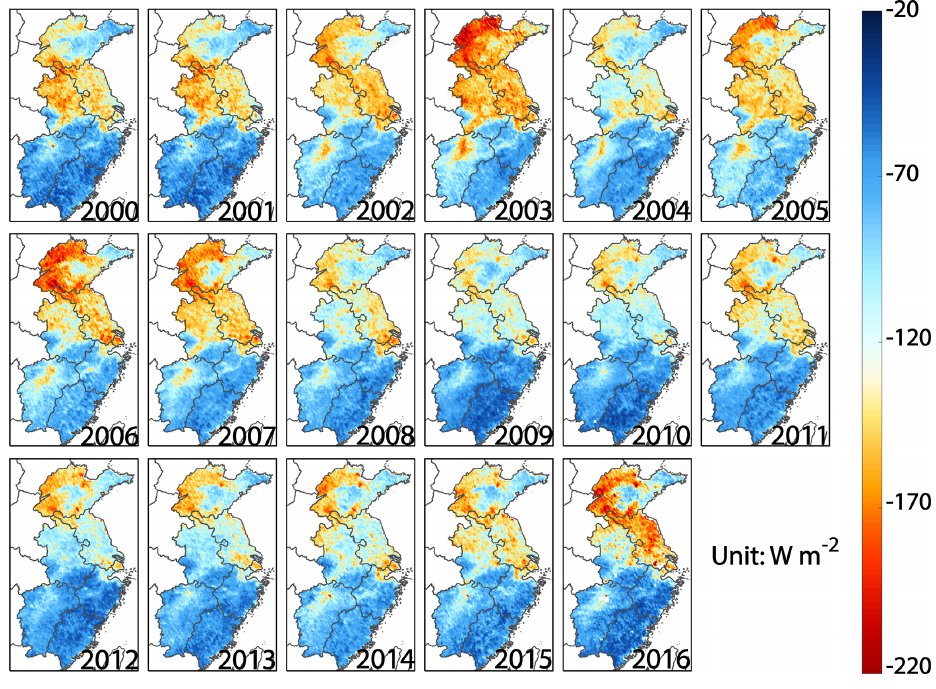
Figure 6. Yearly mean ADRF distributions during 2000–2016 over eastern China (unit: Wm − 2 ).